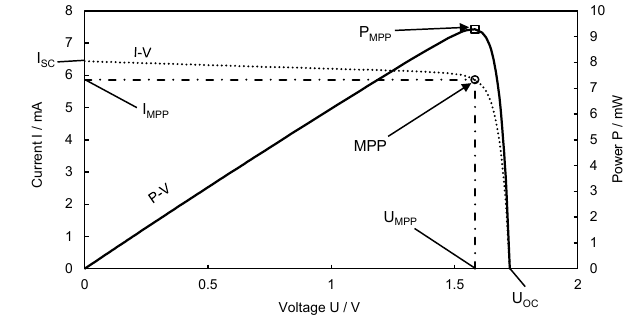
Figure 10. Current-voltage and power-voltage characteristics of the measured red LED.